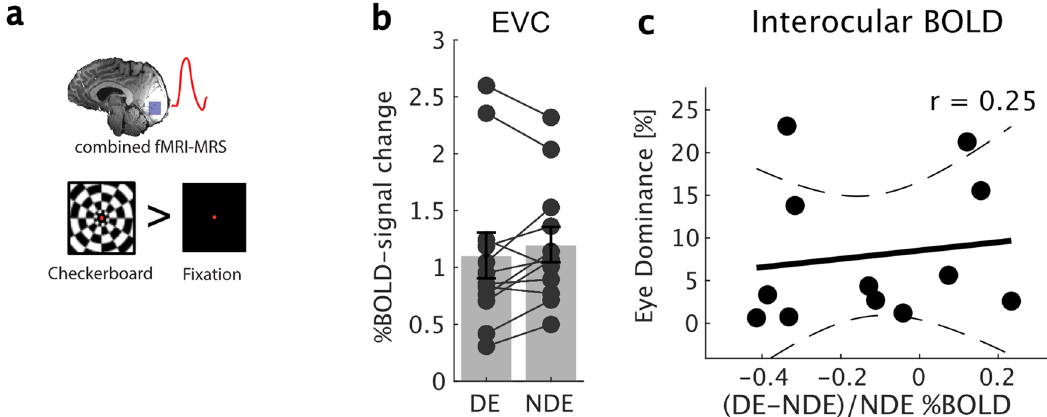
Figure 4. (a) %BOLD-change was obtained by comparing checkerboard > fixation prior to calculating the interocular BOLD metric. (b) %BOLD-signal change to a flashing checkerboard did not differ between dominant and non-dominant eye. (c) There was no relationship between eye dominance and the interocular %BOLD to the flashing checkerboard. Errors are 1 ± SEM. r Spearman’s Rank Correlation. Solid line represents best fitting linear model, hatched lines represent 95% confidence interval of the regression line.